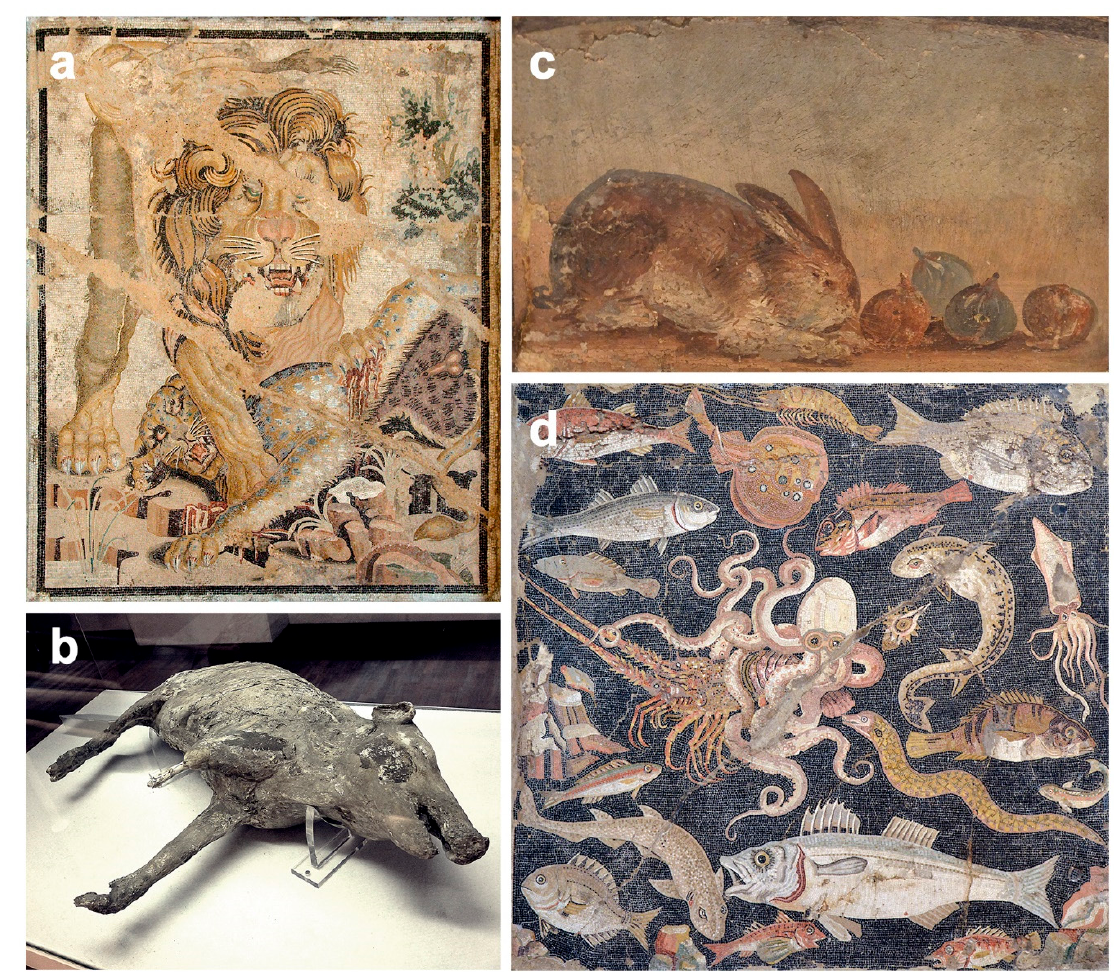
Figure 2. ( a ) Mosaic of a lion attacking a leopard ( House of the Mosaic Doves , Pompeii ). Despite the presence of vegetation in this scene, it seems likely that whoever designed this mosaic had observed these animals not in their natural habitat, but in the arena of Pompeii ’s amphitheatre. Animals were sometimes forced to fight each other after having been starved and tormented to increase their aggression. At other times, animals were part of “hunts” ( venationes ) or pitted against gladiators or criminals condemned to die ( damnatio ad bestias ) [Author: MatthiasKabel. Distributed under a CC BY-SA 2.0 license. Available online: https://cutt.ly/dRCLc99. Accessed: 2 February 2021]. ( b ) Plaster cast of a pig found during the excavation in Villa Regina ( Boscoreale ). It certifies the breeding of pigs on Vesuvian farms [Author: RealCarlo. Distributed under a CC BY 2.0 license. Available online: https://cutt.ly/KRCLFFl. Accessed: 30 October 2021]. ( c ) Fresco of a rabbit and four figs (from